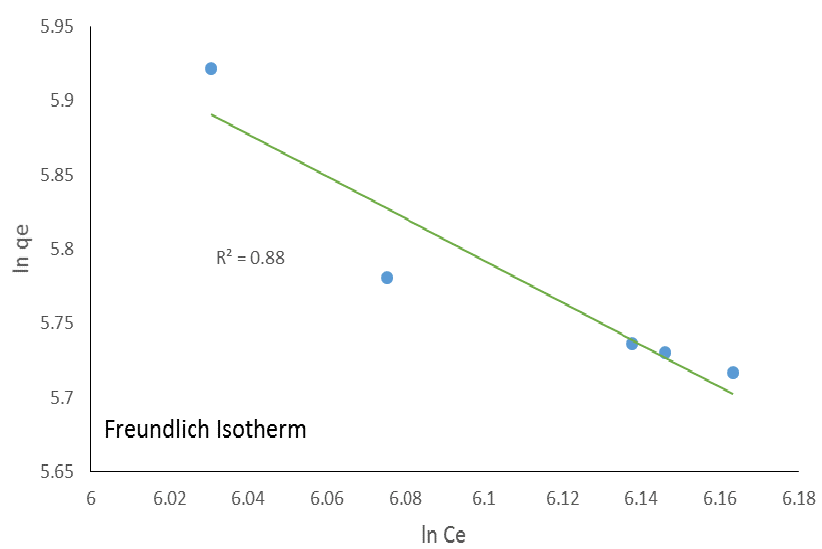
Fig. 8: Freundlich Isotherm for adsorption of Methylene blue OPKS based activated carbon